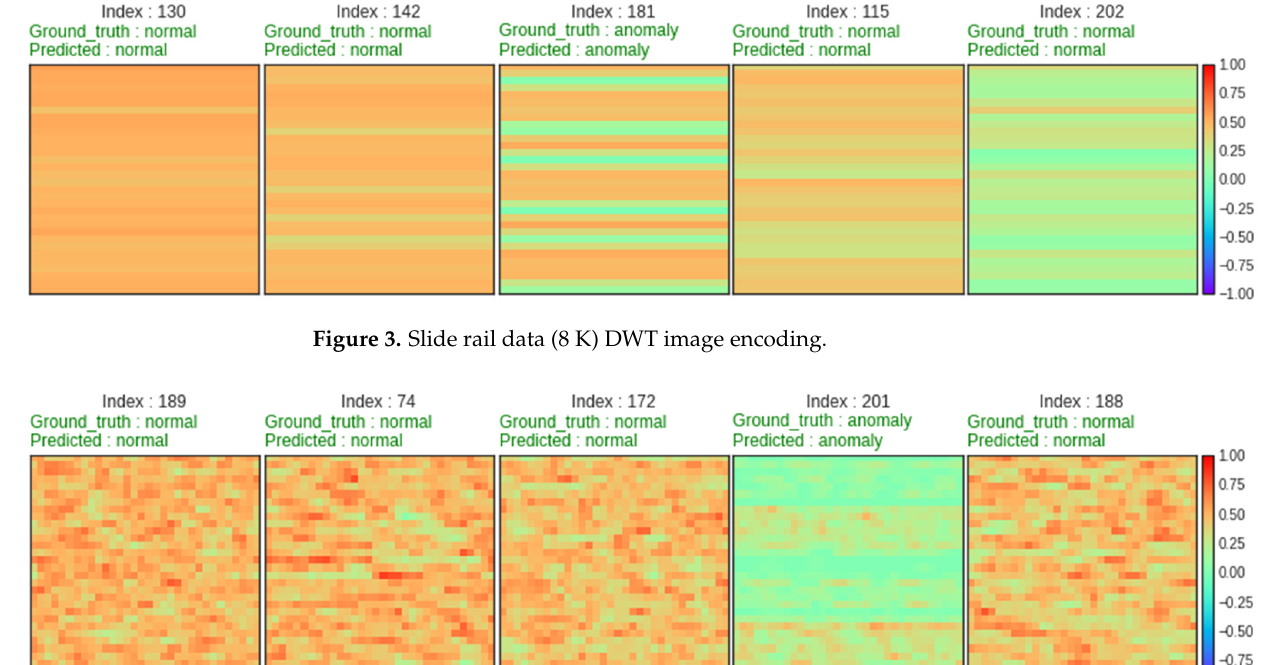
Figure 2. Slide rail data (4 K) DWT image encoding.